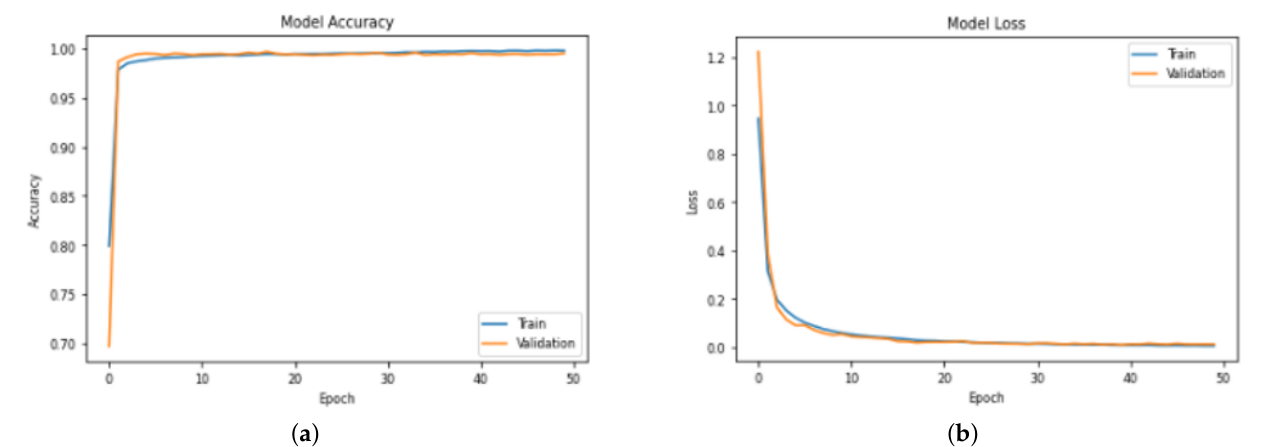
Figure 5. ( a ) Model Accuracy, ( b ) Model Loss.